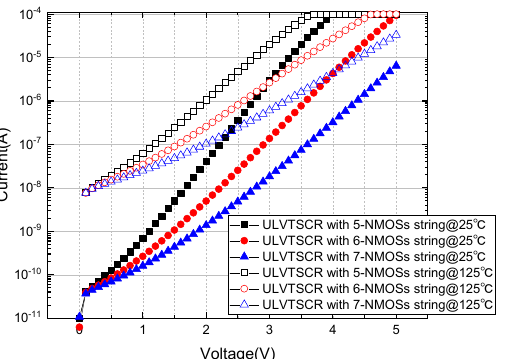
Figure 7. DC sweeps of the ULVTSCR with different NMOSs string. Measured at 25 ◦ C and 125 ◦ C. Table 3. Extracted leakage of ULVTSCR with different NMOSs string at 25 ◦ C and 125 ◦ C.